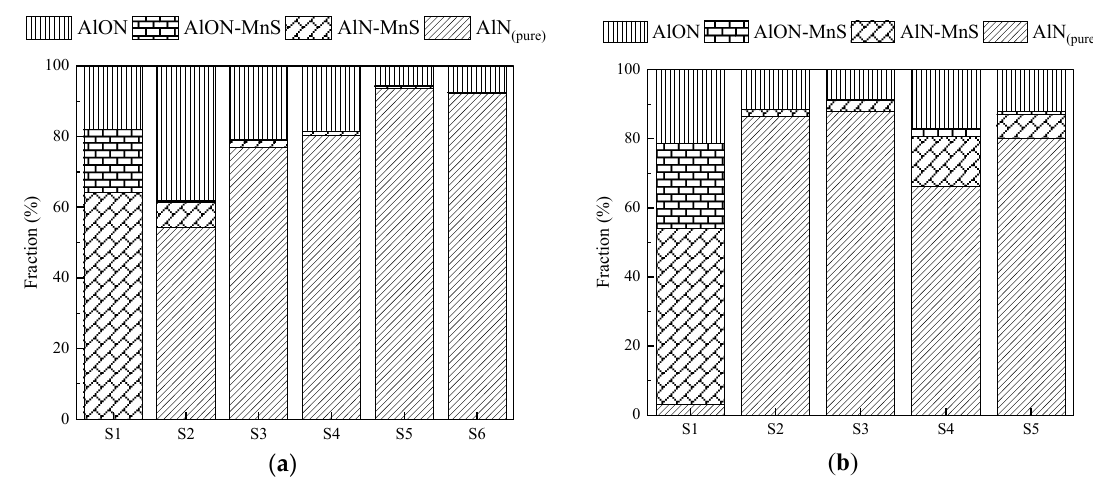
Figure 3. The fraction of subclasses of AlN inclusions for ( a ) 533N-P and ( b ) 533N-I steels.